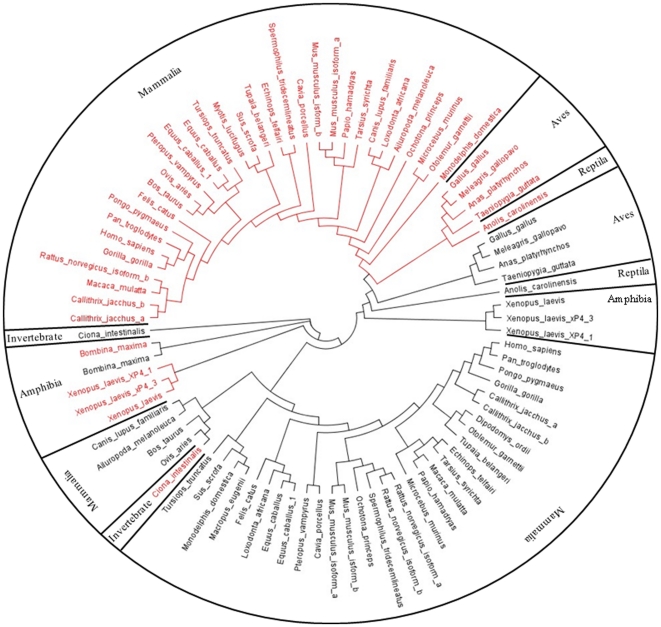
Phylogenetic tree of trefoil domains of TFF2.TD1 (red) and TD2 (black) were extracted from a range of animals as listed in Figure 4, aligned by using ClustalW, and analyzed with the neighbor-joining method.